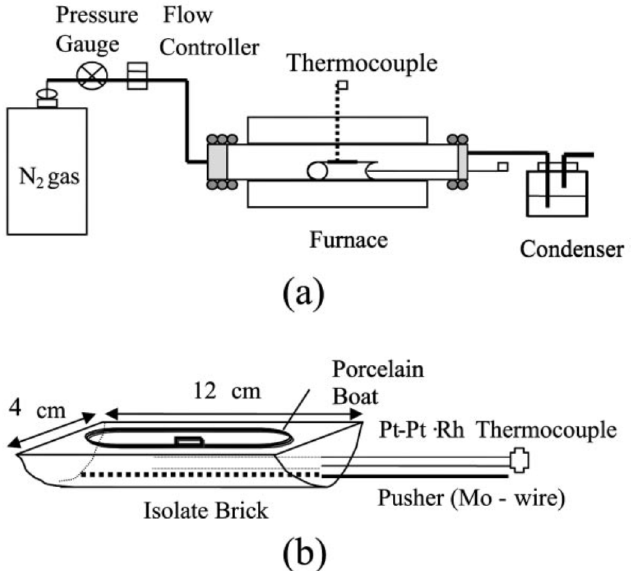
Figure 5. Schematic of the experimental apparatus for activation ( a ), and sample boat ( b ). Reproduced with permission from [15], ©2001 Elsevier Science B.V.